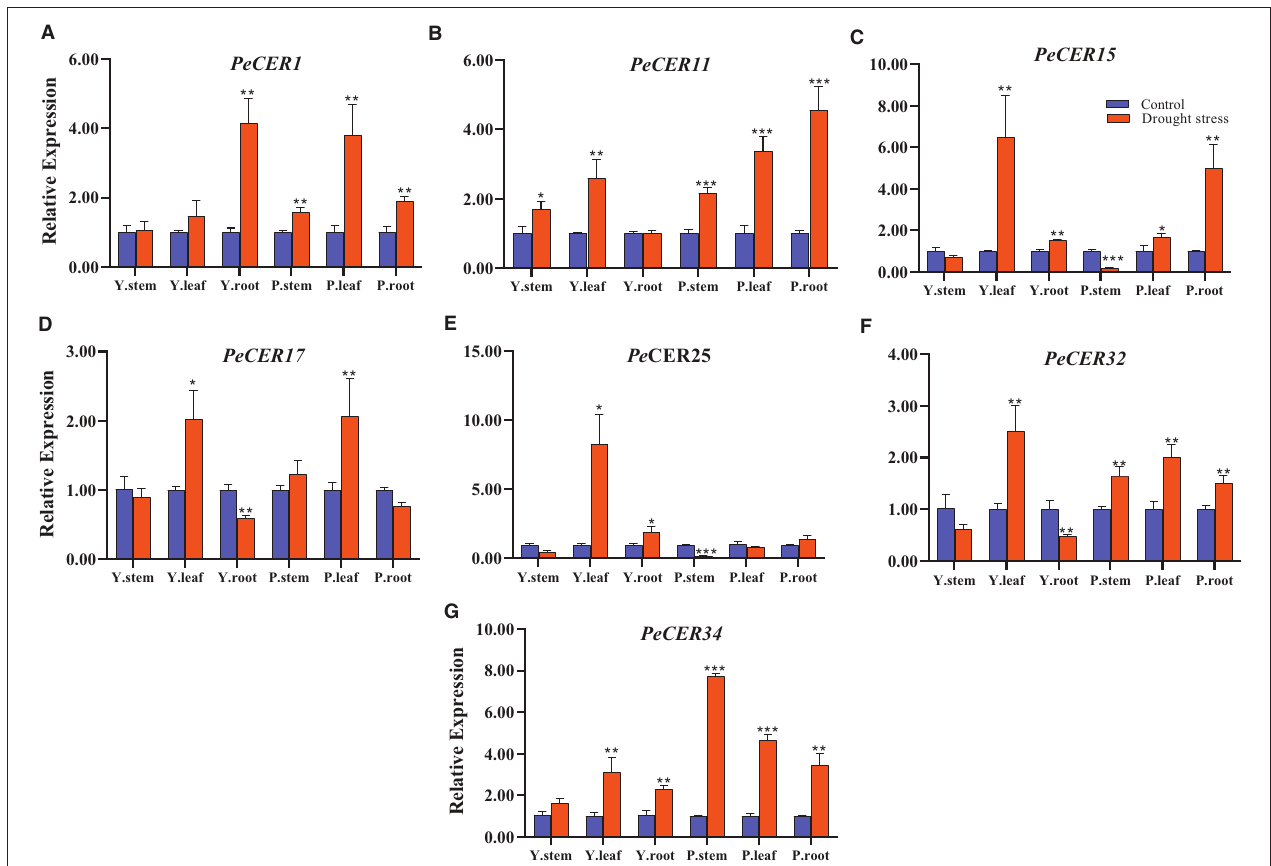
FIGURE 12 | Relative expressions of PeCER genes (A–G) in stem, root, and leaf tissues of yellow and purple passion fruit plants under control and drought stress conditions. Relative gene expression levels were calculated using 2 − 11 ct . Plants with regular watering were taken as control. Vertical bars represent means ± SD ( n = 3). *, **, and *** show significance at p ≤ 0.05, p ≤ 0.01, and p ≤ 0.001, respectively, under control and drought stress condition according to Students t -test. Y represents yellow passion fruit, and P represents purple passion